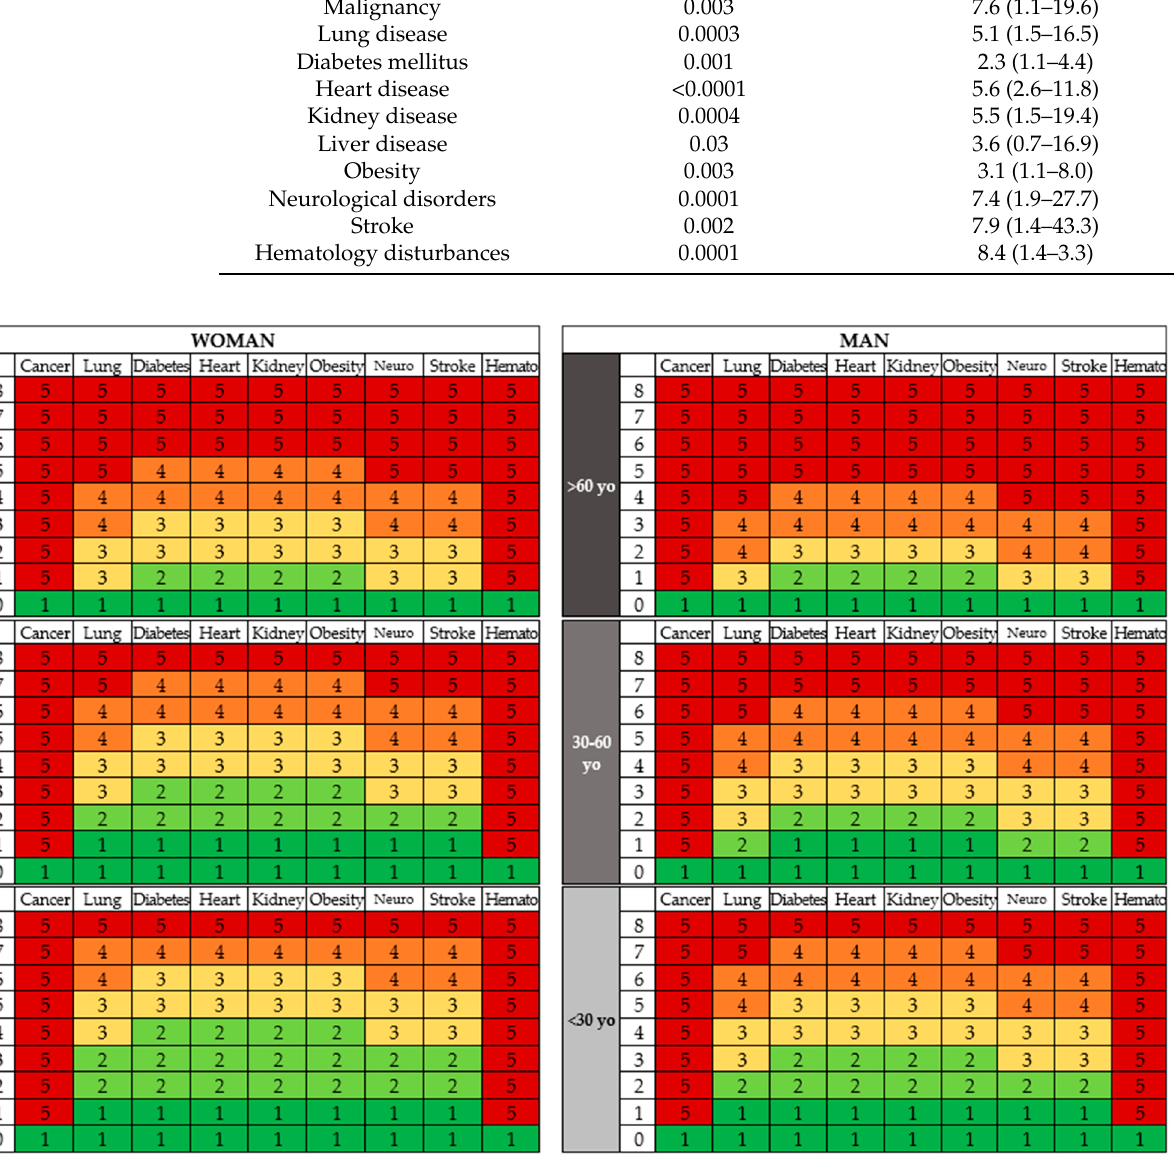
Figure 1. The prediction matrix.